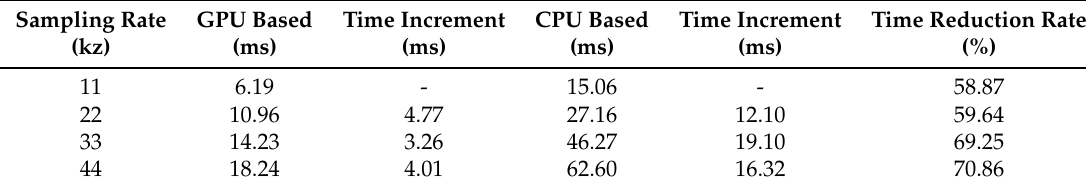
Figure 9. ( a ) Execution time of algorithm according to the number of particles ( b ) Partial execution time of algorithm according to the number of particles. Table 2. Execution time of algorithm according to the sampling